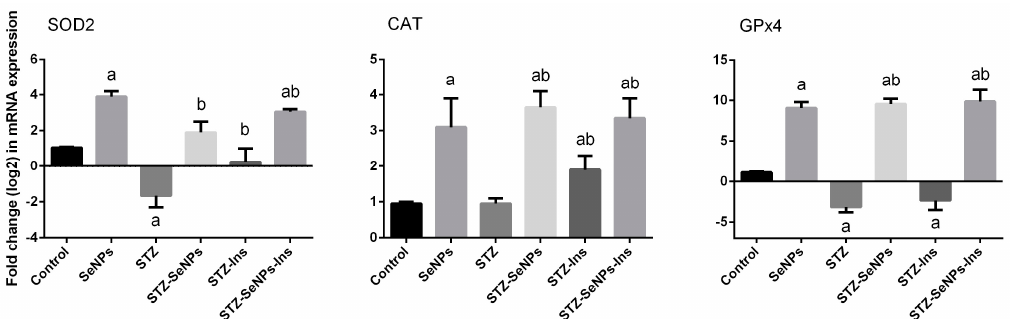
Figure 5. Impact of SeNPs and/or insulin on gene expression of antioxidant enzymes in the testis of control and STZ-diabetic rats. Results (mean ± SEM of the triplicate) were settled according to the mRNA level of β -actin and are shown as fold induction (in log2 scale) of the mRNA level in the control. SOD2 : superoxide dismutase isoform 2; CAT: catalase and GPx4: phospholipid hydroperoxide glutathione peroxidase.